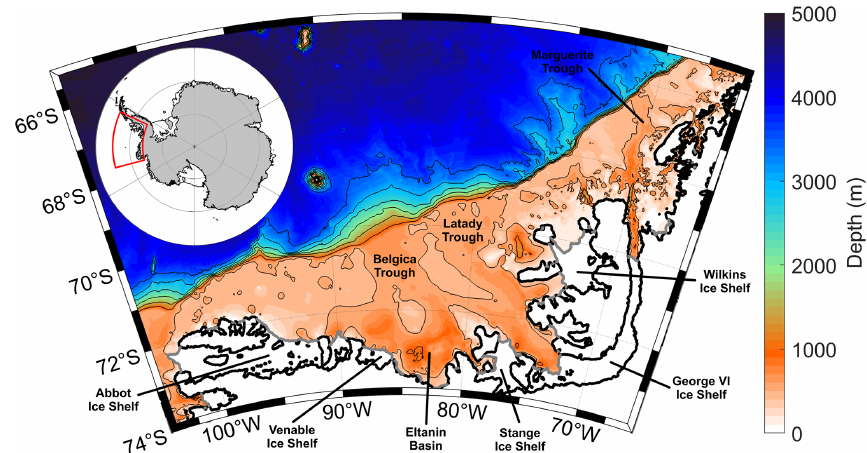
Figure 1. Bathymetry of the Bellingshausen Sea and West Antarctic Peninsula continental shelves (red box in the inset plot) as given by the RTopo2 data product (Schaffer et al., 2016). Thin black contours delineate isobaths between 0 and 3000m, with a 500m interval. Thick black and gray lines indicate the coastline and the edge of permanent ice shelves, respectively. Key geographic features are